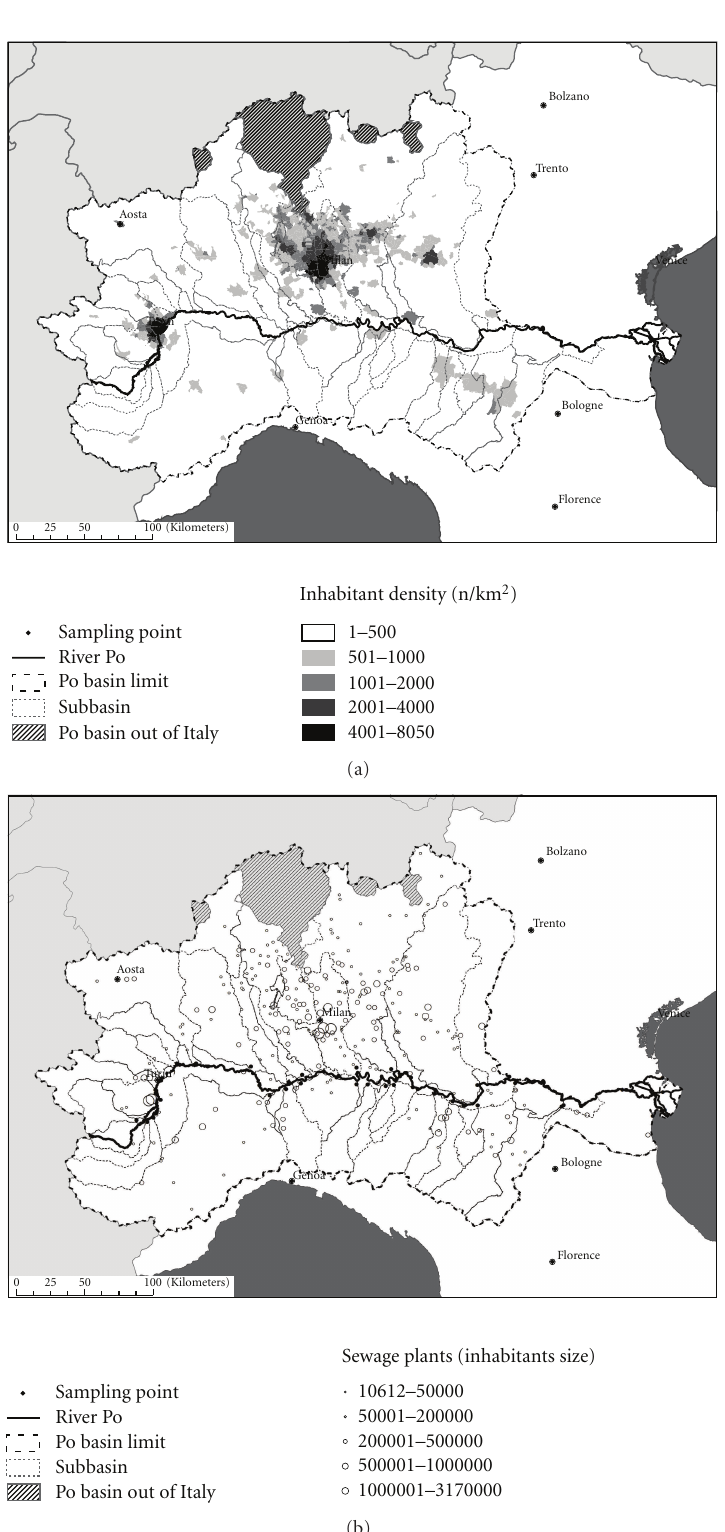
Figure 2: Inhabitant distribution (a) and sewage plants distribution (b) in river Po basin and its